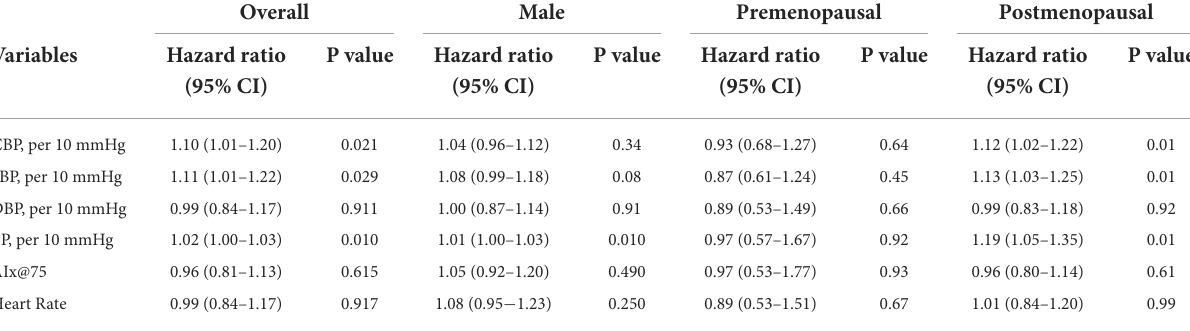
TABLE 3 Multivariate Cox proportional hazards